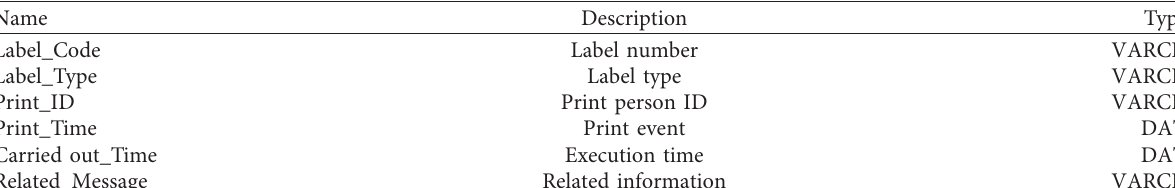
Figure 4: Optimized clinical care management system module Table 1: Field description of the label printing record table.